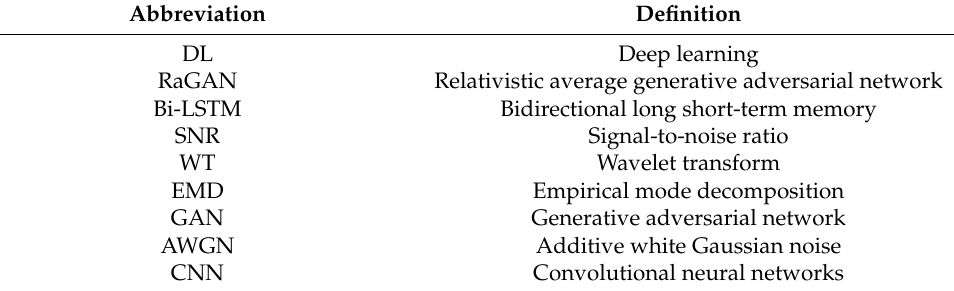
Table 1. List of